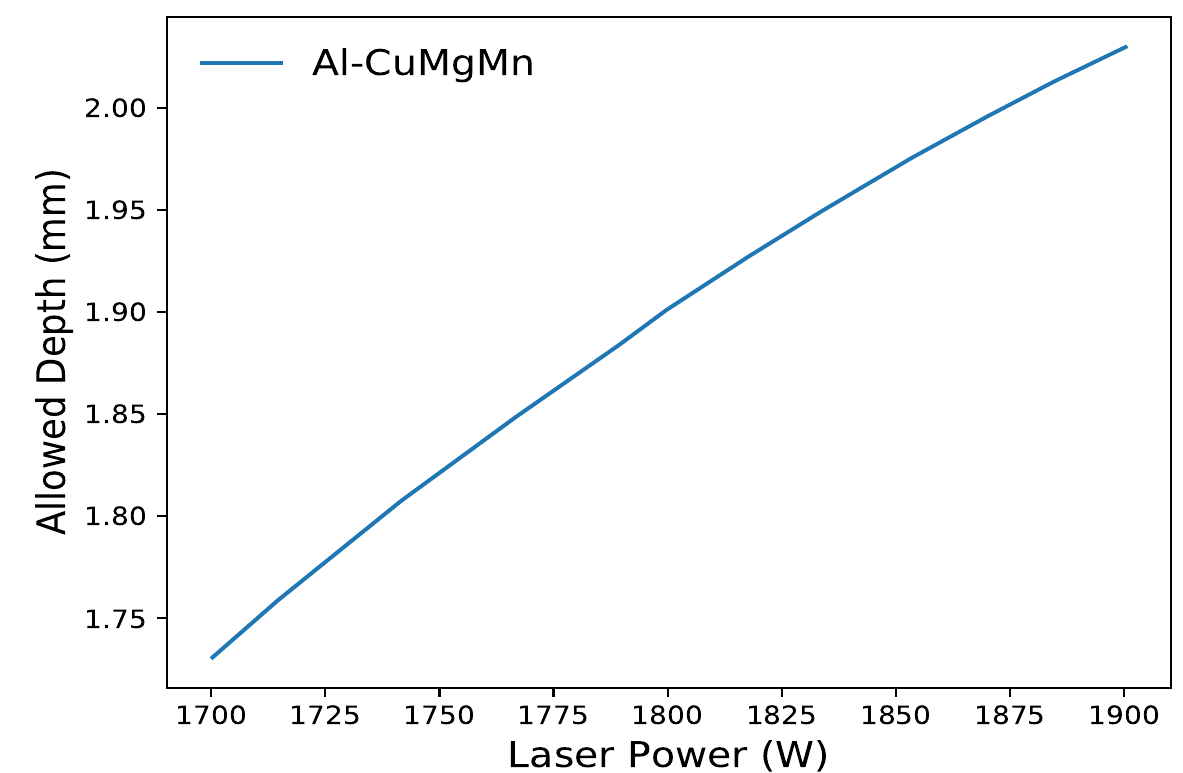
Figure 4. The effect of laser power on alloyed depth with laser beam spot diameter of 5.8 mm and laser scan speed of 5 mm/s.